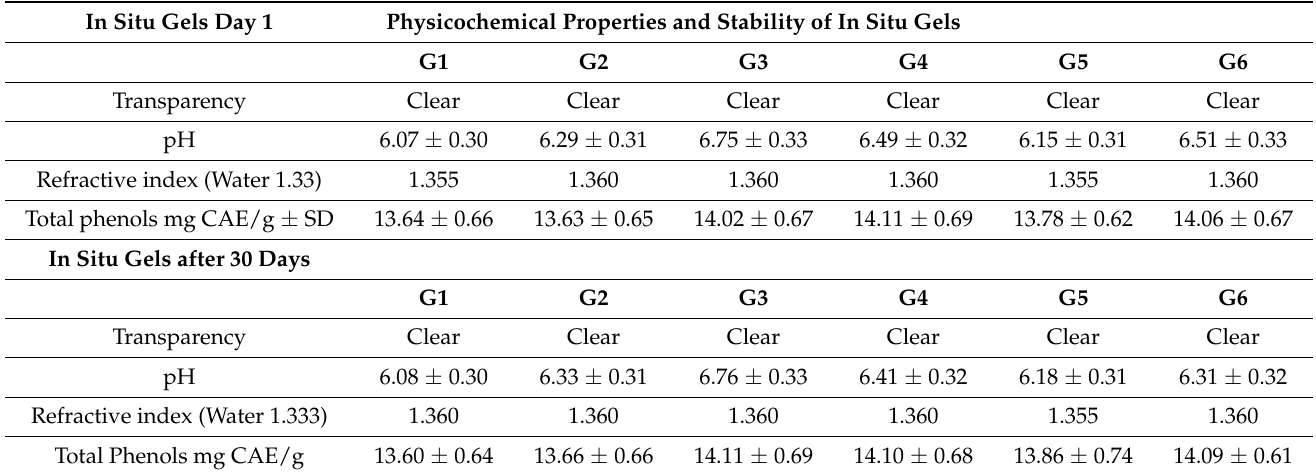
Table 5. Stability parameters of formulations G1–G6 on day 1 and after 30 days (mean ± SD, n = 3). In Situ Gels Day